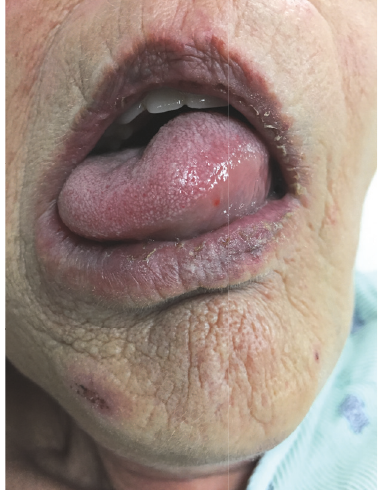
Figure 1: Image showing left lingual